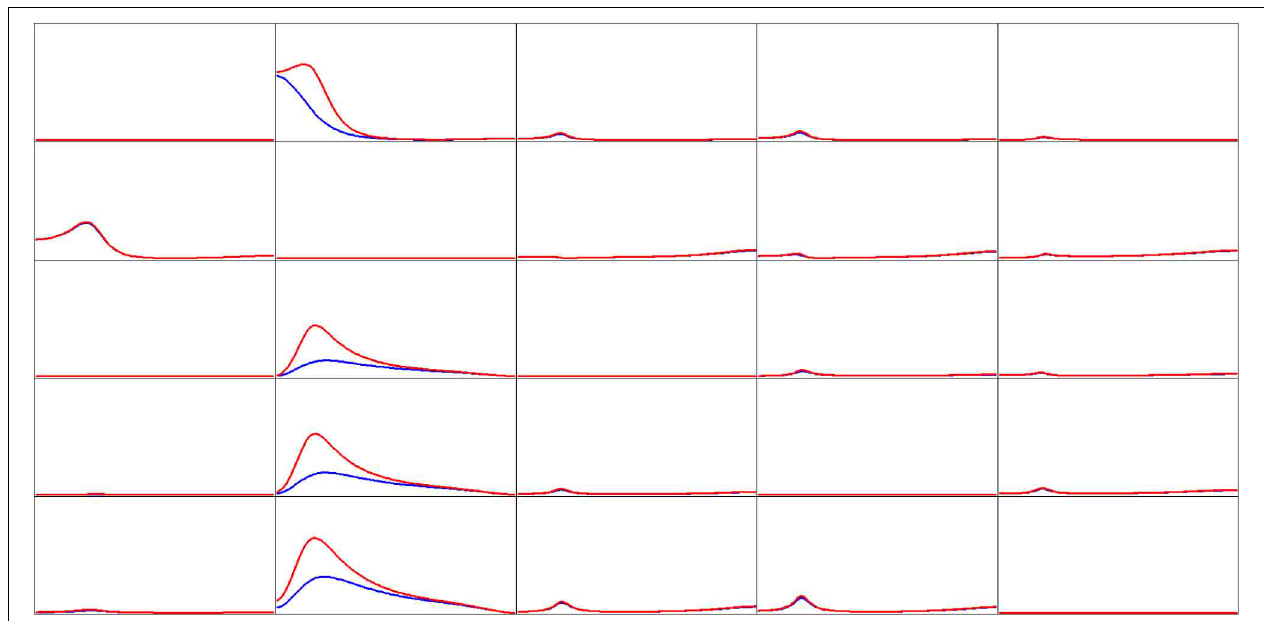
FIGURE 4 | Estimated connectivity properties for simulated EEG signals (see Figure 2). Isolated effective coherence (iCoh) shown in RED, and the generalized partial directed coherence (gPDC) shown in BLUE. Vertical axis: 0 to 1. Frequency axis: 1 to 127Hz. Columns are senders, rows are receivers.